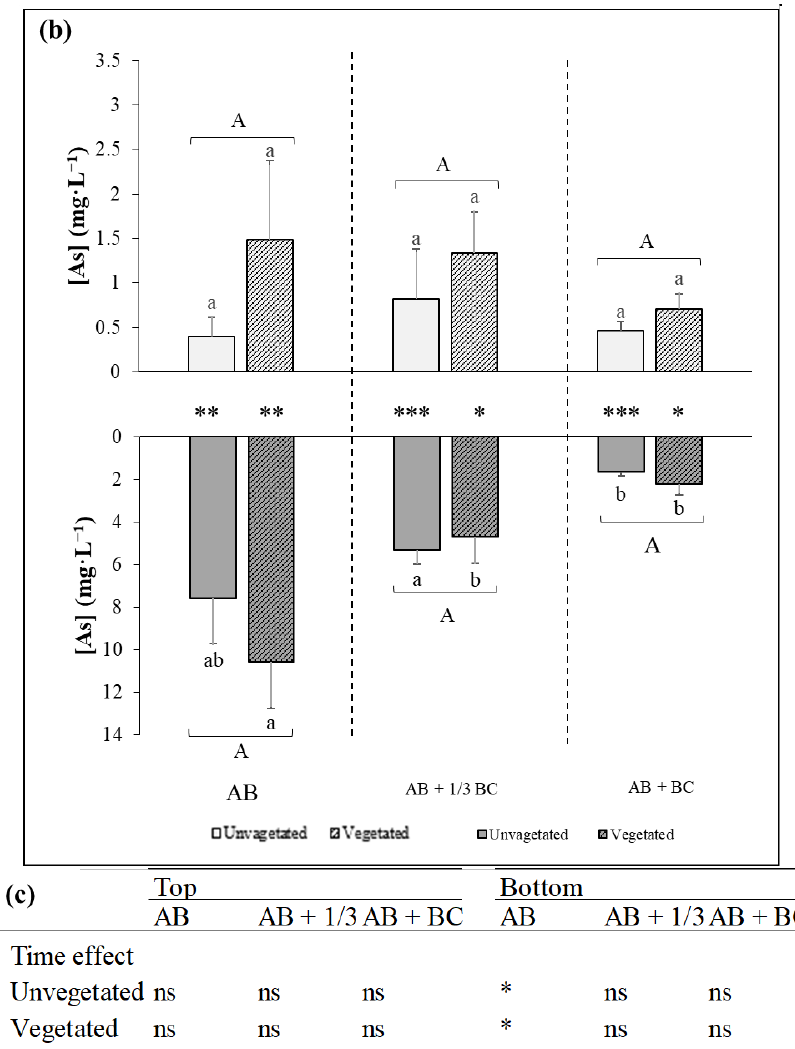
Figure 2. Soil pore water (SPW) arsenic concentration ([As] = mg·L − 1 ) is mean of seven values (± SE), determined on Abbaretz (AB) technosol non amended or amended with 2% biochar added to the top 33 cm of the tube (AB + 1/3 BC) or the entirety of the tube (AB + BC) in the unvegetated tubes and in the tubes vegetated with Alnus sp. SPWs were sampled both at the top (light gray box) and at the bottom (gray box) of the tubes in ( a ) October 2019 (T7) and ( b ) October 2020 (T19). The treatment effect in the vegetated and unvegetated conditions (taken separately, the level effect for each treatment/(un)vegetated condition and the ( c ) time effect between T7 and T9 are given with level of significance: ns = non-significant ( p ≥ 0.05); * ( p ≤ 0.05); ** ( p ≤ 0.01); *** ( p ≤ 0.001).